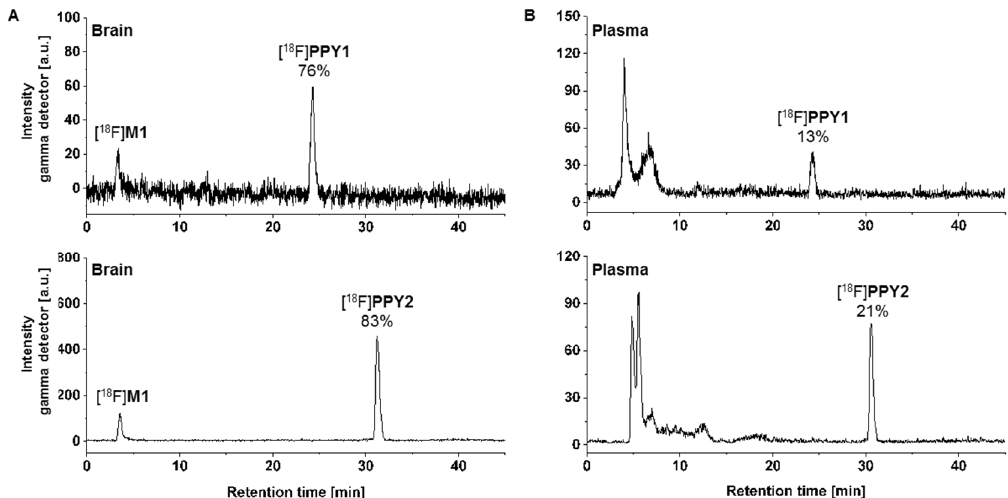
Figure 7. In vivo metabolism study in CD-1 mice: Representative radio-chromatograms of extracted ( A ) brain and ( B ) plasma samples at 30 min p.i. of [ 18 F] PPY1 [ReproSil-GOLD 120 C18 column (250 × 4.6 mm, 5 µm), 10-90-10% MeCN/H 2 O, flow rate: 1 mL/min] and [ 18 F] PPY2 [ReproSil-Pur 120 C18-AQ column (250 × 4.6 mm, 5 µm) 10–90–10% MeCN/H 2 O, flow rate: 1 mL/min].